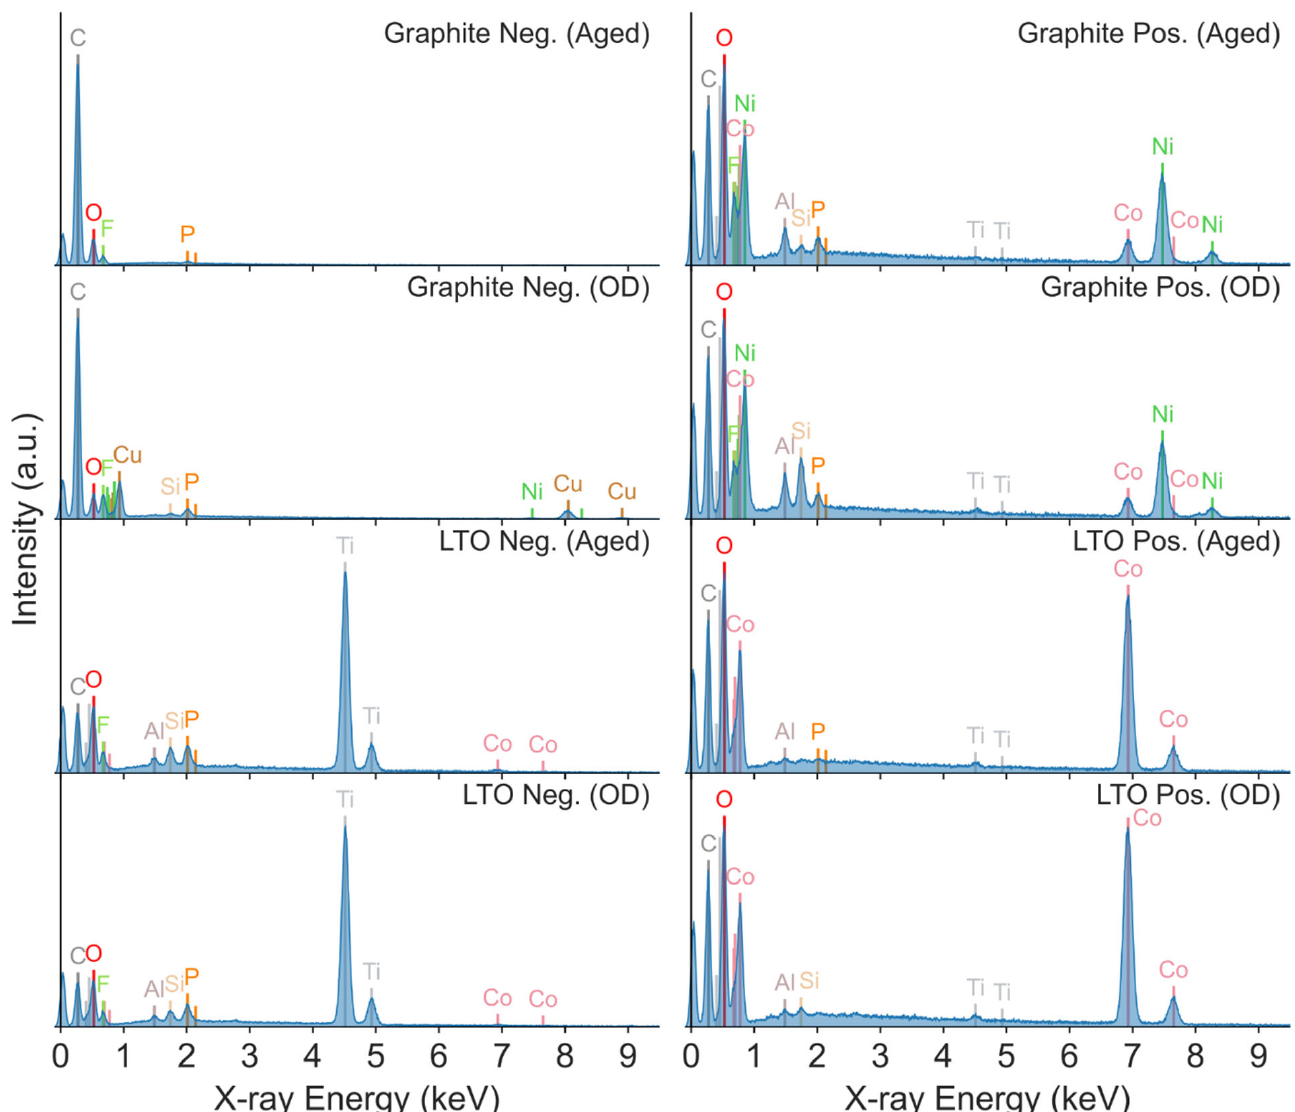
Figure 9. Energy-dispersive X-ray spectroscopy (EDS) spectra of the cross-sectioned electrodes. The left column shows the negative electrode spectra; the right column shows the positive electrode spectra. Top row: a graphite cell after aging at 45 °C. Second row: a graphite cell after overdischarge testing. Third row: an LTO cell after aging at 45 °C. Bottom row: an LTO cell after overdischarge testing. All spectra are normalized to the maximum peak height. Atomic X-ray lines are marked and colored using the Jmol color scheme [12].